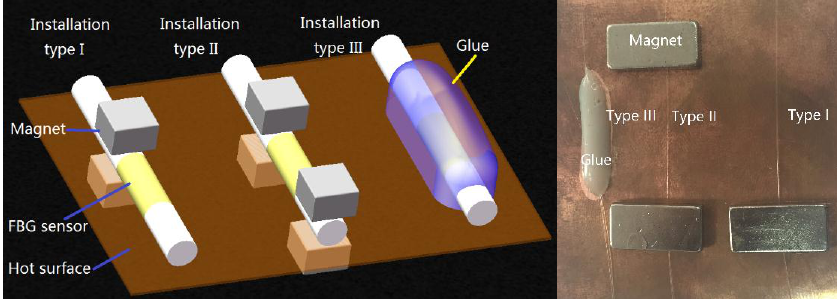
Figure 8. Schematic diagram and photograph of three common installation types of sensor.